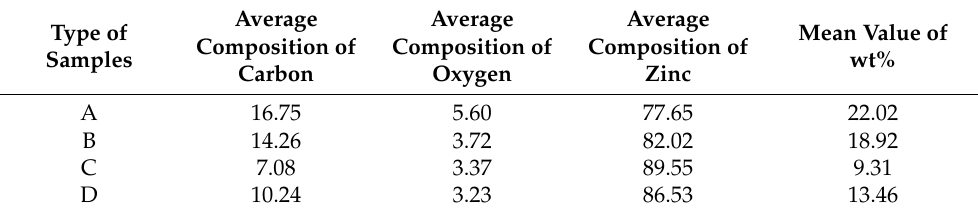
Table 3. Composition of hybrid coatings obtained from EDX analysis.